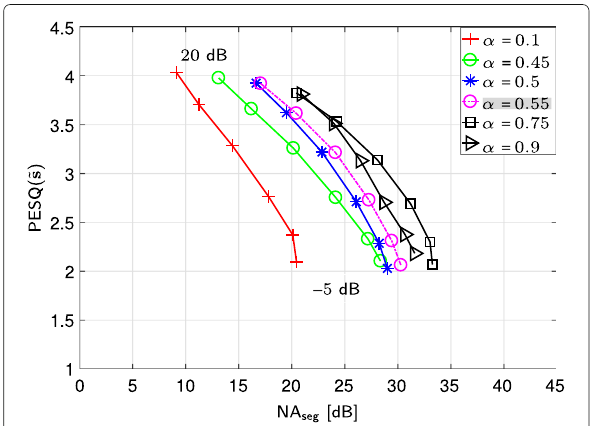
Fig. 5 Noise attenuation NA seg vs. speech component quality PESQ s for different parameters for the reference iIRM MSE (10) on 12 . 5 % ofthevalidationset . From top to bottom, the markers are corresponding to six SNR conditions from 20 to 5dB with a step size of 5dB. The selected setting 0.55 is gray-shaded in the legend